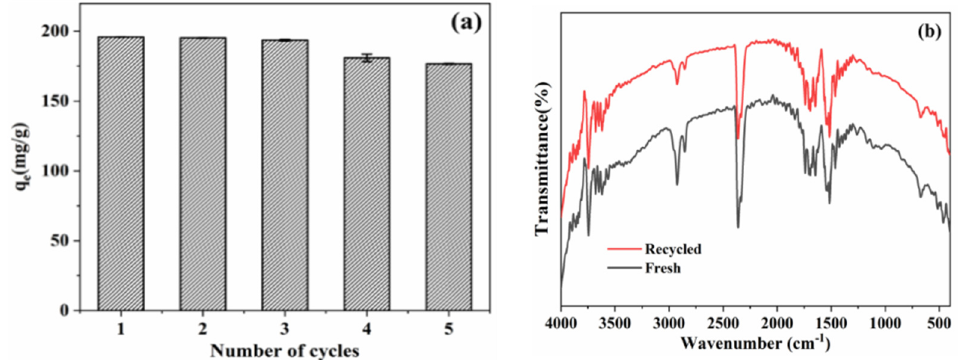
Figure 9. ( a ) The reusability of the P-POPs for the removal of TC and ( b ) FT-IR spectra of the recycled P-POPs-3.